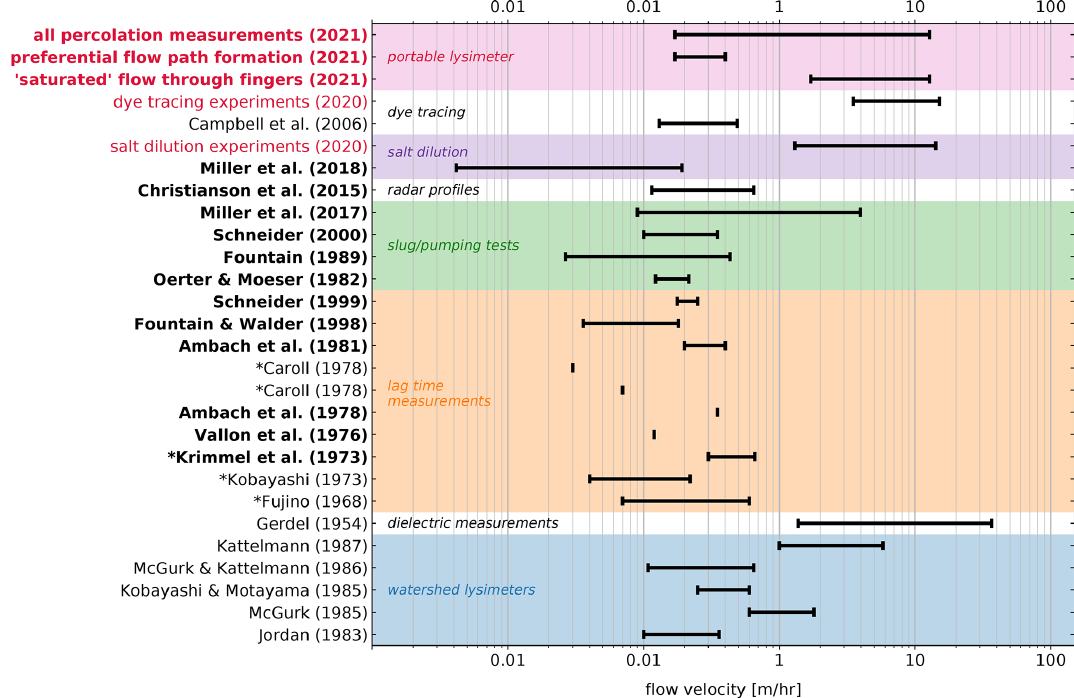
Figure 12. Flow velocities through snow (regular font) and firn (bold font) as measured in this study (in red), compared to other values published in the literature. Author names preceded by an ∗ indicate that the original papers were not available, but quoted values were found in Kattelmann